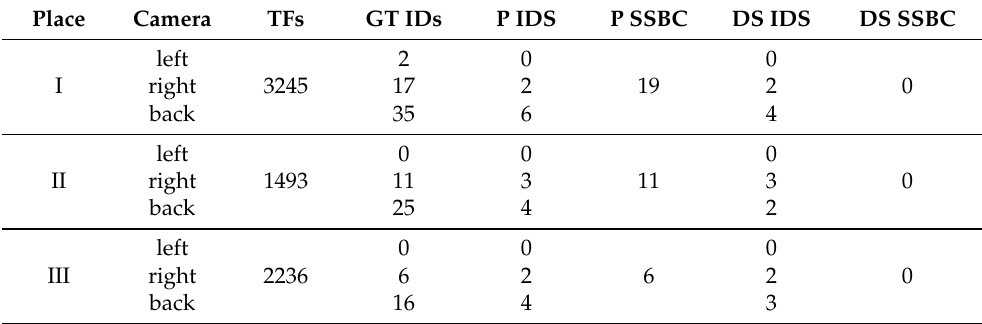
Table 3. Experiment III (tracking model) results. TFs = Total Frames, GT IDs = Number of Ground Truth IDs, IDS = Number of ID Switches, P = Proposed Model, DS = DeepSORT, SSBC = Number of Successful Switches Between